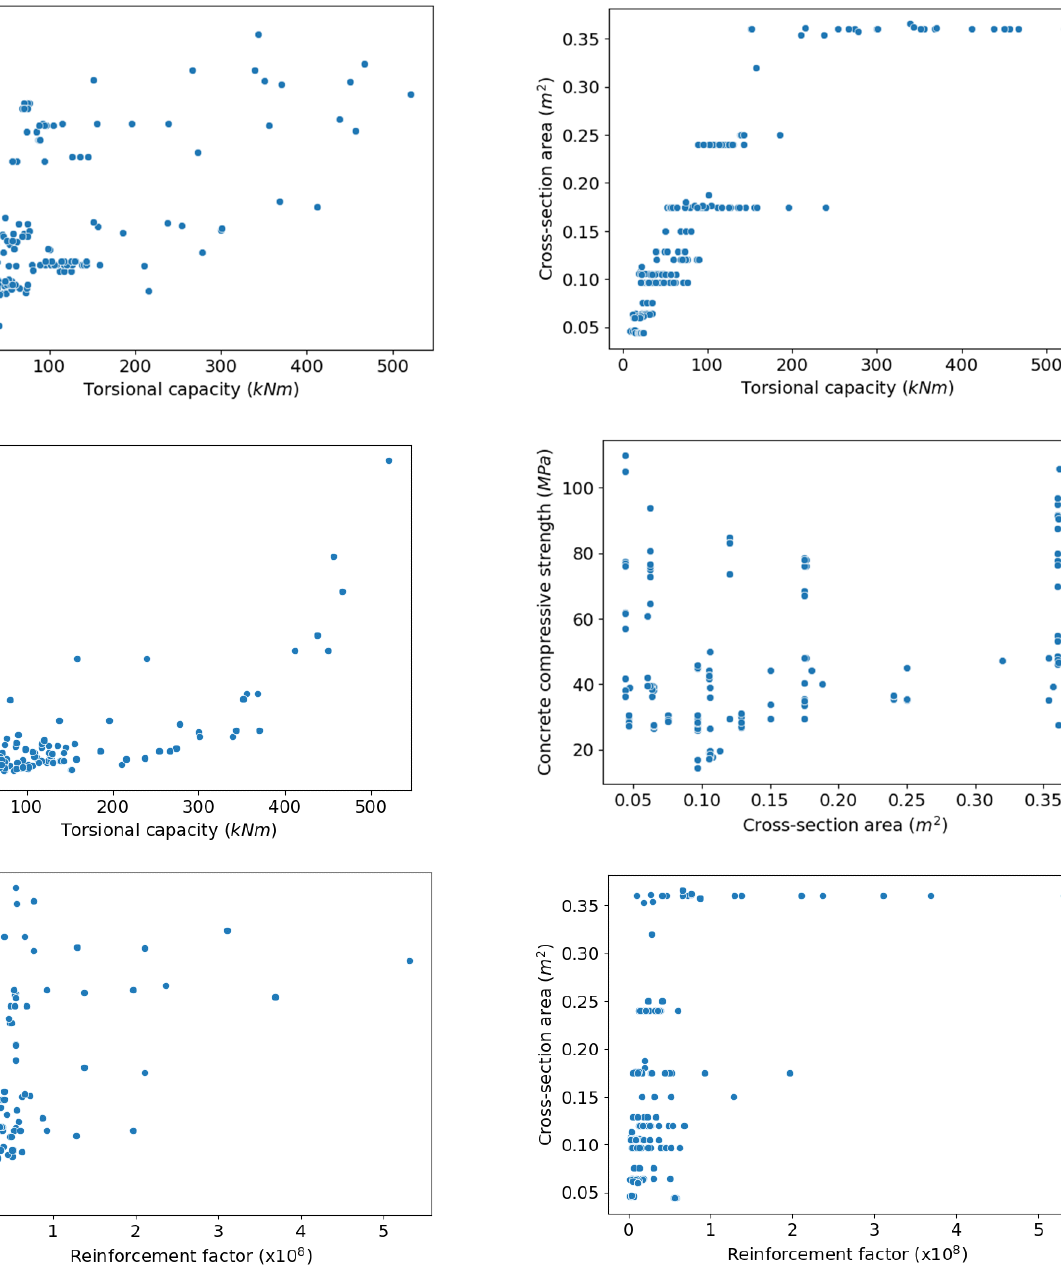
Figure 4. Scatter plot between pairs of variables.